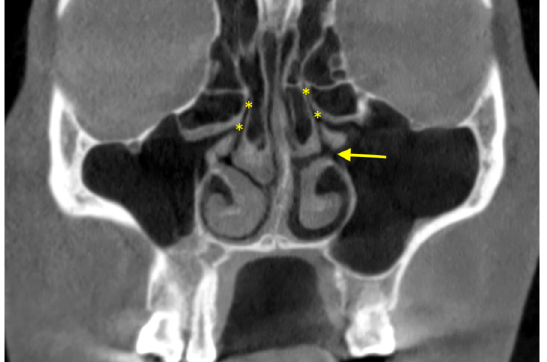
Figure 3. Primary ostium (asterisk) in both maxillary sinuses and accessory ostium (arrow) in the left maxillary sinus.